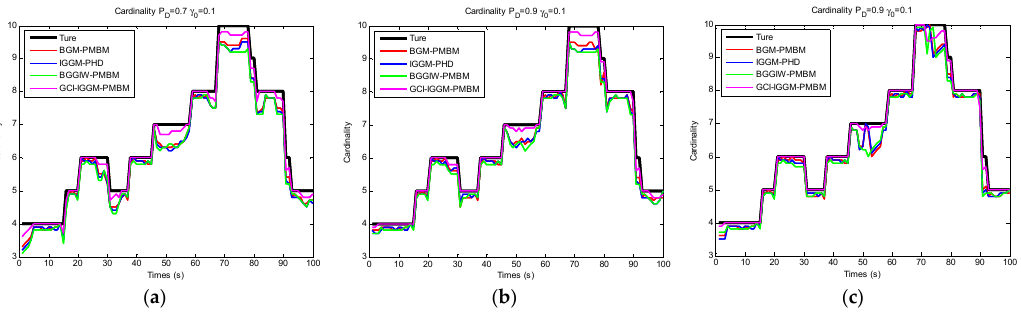
Figure 5. Cardinality comparisons of GCI–IGGM–PMBM (our proposed scheme) with other multitarget tracking schemes: ( a ) p D = 0.7; ( b ) p D = 0.9; ( c ) p D =